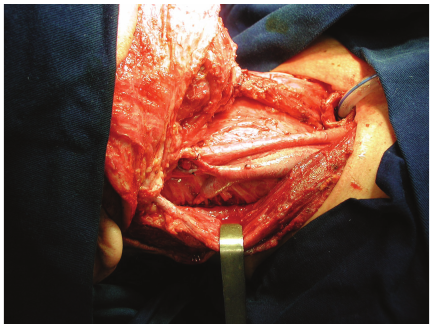
Figure 3: Right modified neck dissection (preserving the right thyrolinguofacial trunk and the right IJV distal